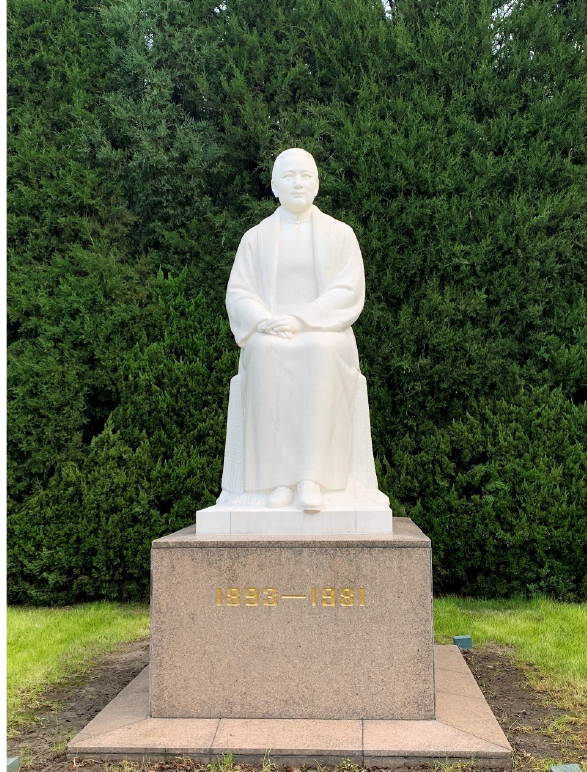
Figure 1 . Soong Ching Ling’s dolomite marble statue, 2021, Shanghai, P.R. China. (Source: Zhong